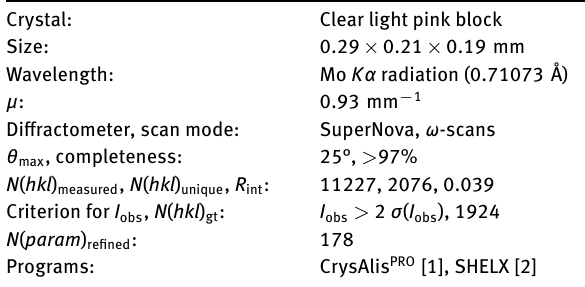
Table 2: Fractional atomic coordinates and isotropic or